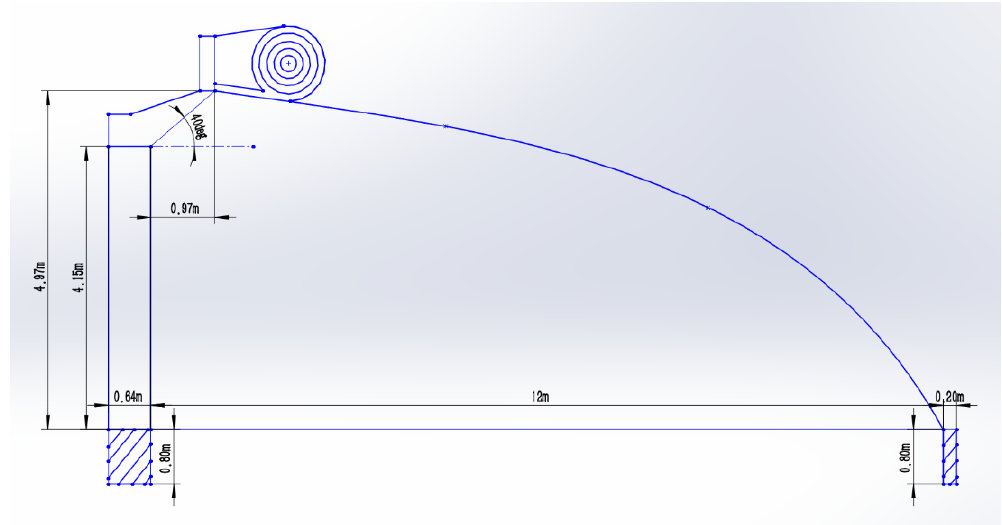
Figure 10. Cross-section of a conceptual CSG in Saskatoon.